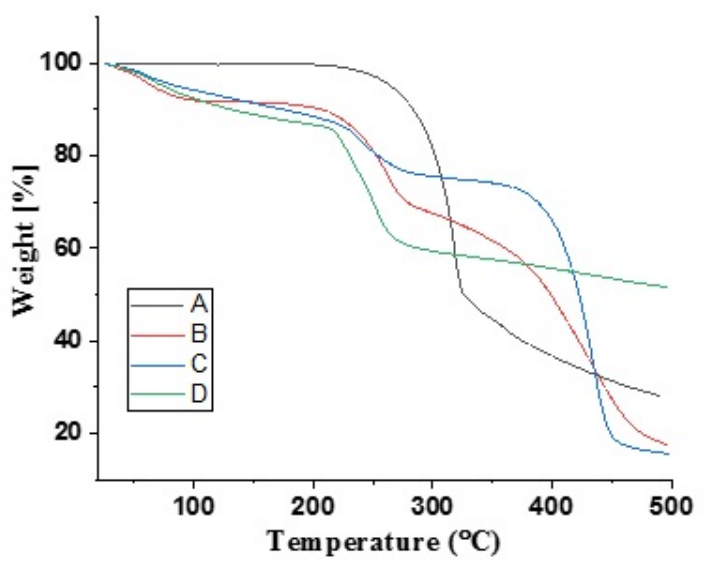
Figure 7. TGA thermograms of ( A ) DF, ( B ) Na-Alg, ( C ) CP-934P, ( D ) DF-loaded Na-Alg/CP-co-poly (methacrylate) (methacrylate) hydrogel.